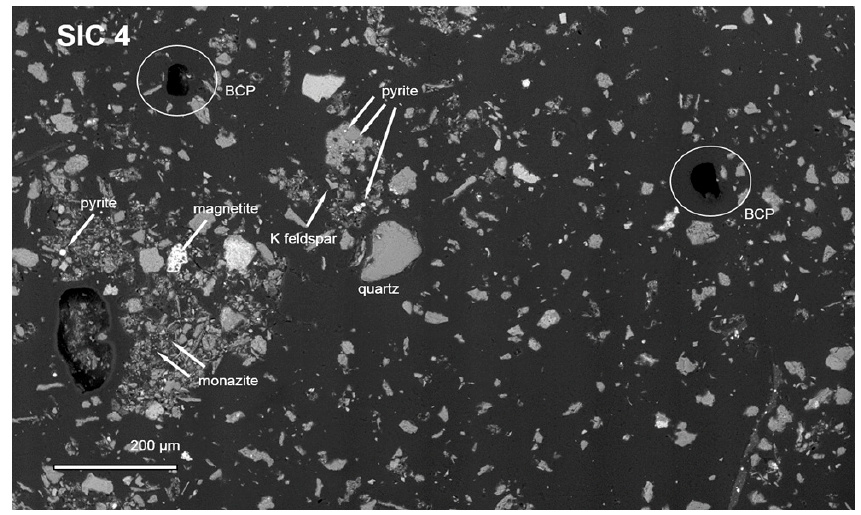
Figure 4. Cryodust in a secondary electron image of uncoated dust sample SIC2-SIC4 from Storbreen. SEM. Particles of elemental carbon (BCPs) are shown circled. Sample SIC 4.